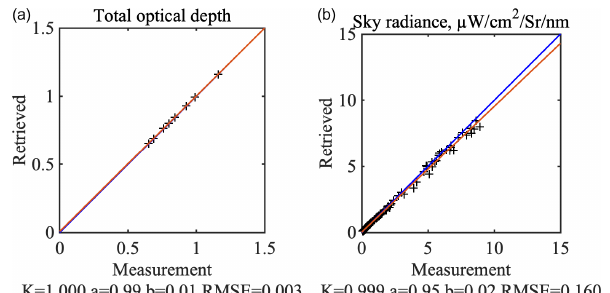
Figure 15. Achieved total optical thickness (a) and sky radi- ance (b) fits for the multi-temporal retrievals performed on 15– 16 April 2015.